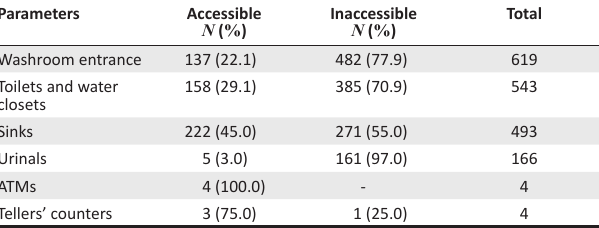
TABLE 4: Distribution of washrooms, toilets, sinks, urinals, automated teller machines and tellers’ counters accessible to wheelchair users.